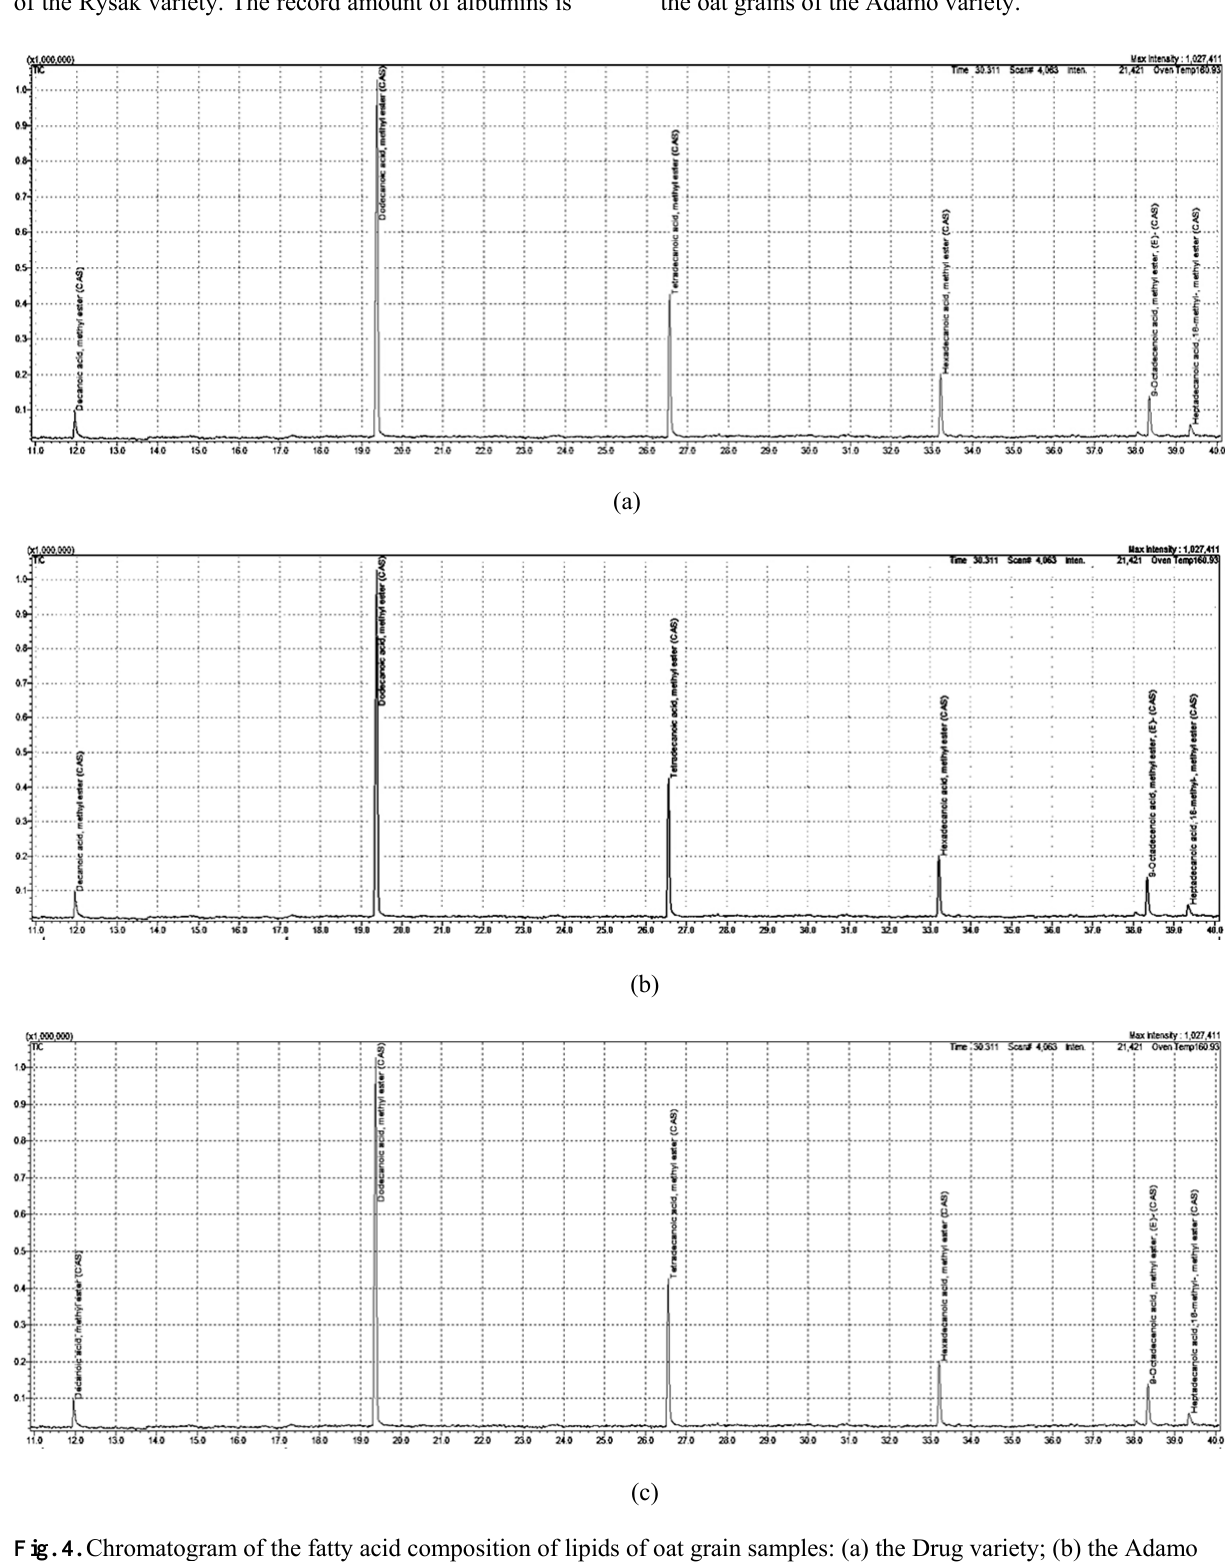
Fig. 4. Chromatogram of the fatty acid composition of lipids of oat grain samples: (a) the Drug variety; (b) the Adamo variety; (c) the Rysak